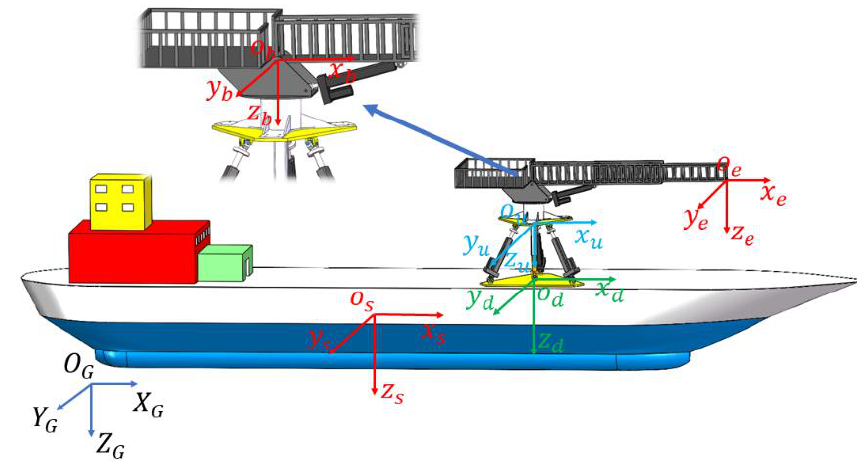
Figure 2. The offshore gangway ’ s frames.